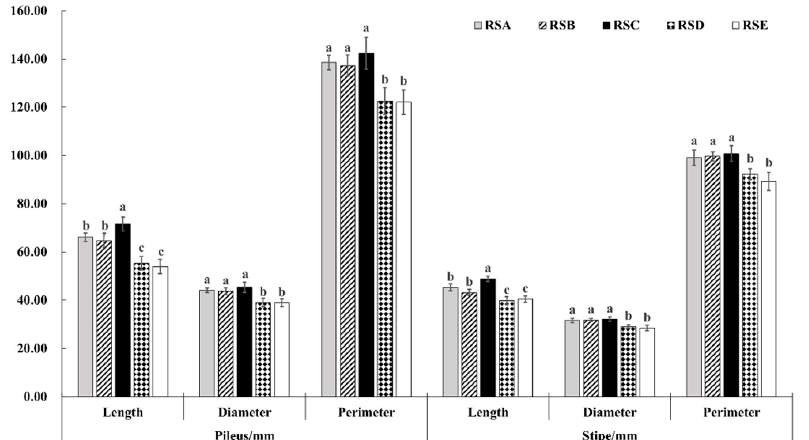
Figure 1. Effect of different rotation systems on morphological characteristics of M. importuna , including the length, diameter, and perimeter of the fruitbody (pileus and stipe); different letters indicate the statistical difference ( p < 0.05).